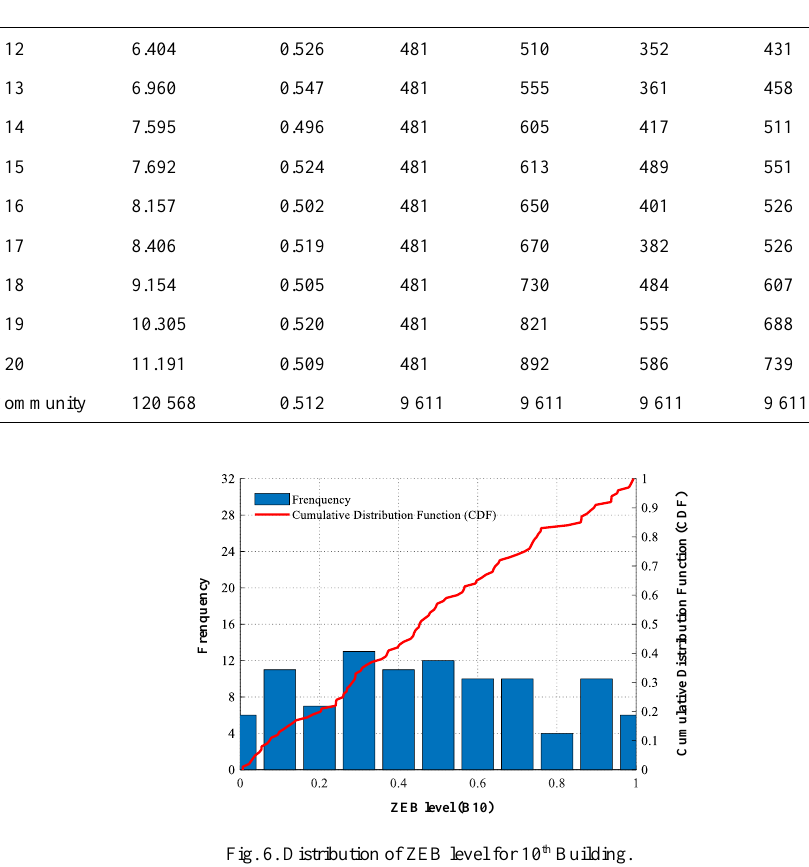
Fig. 6. Distribution of ZEB level for 10 th